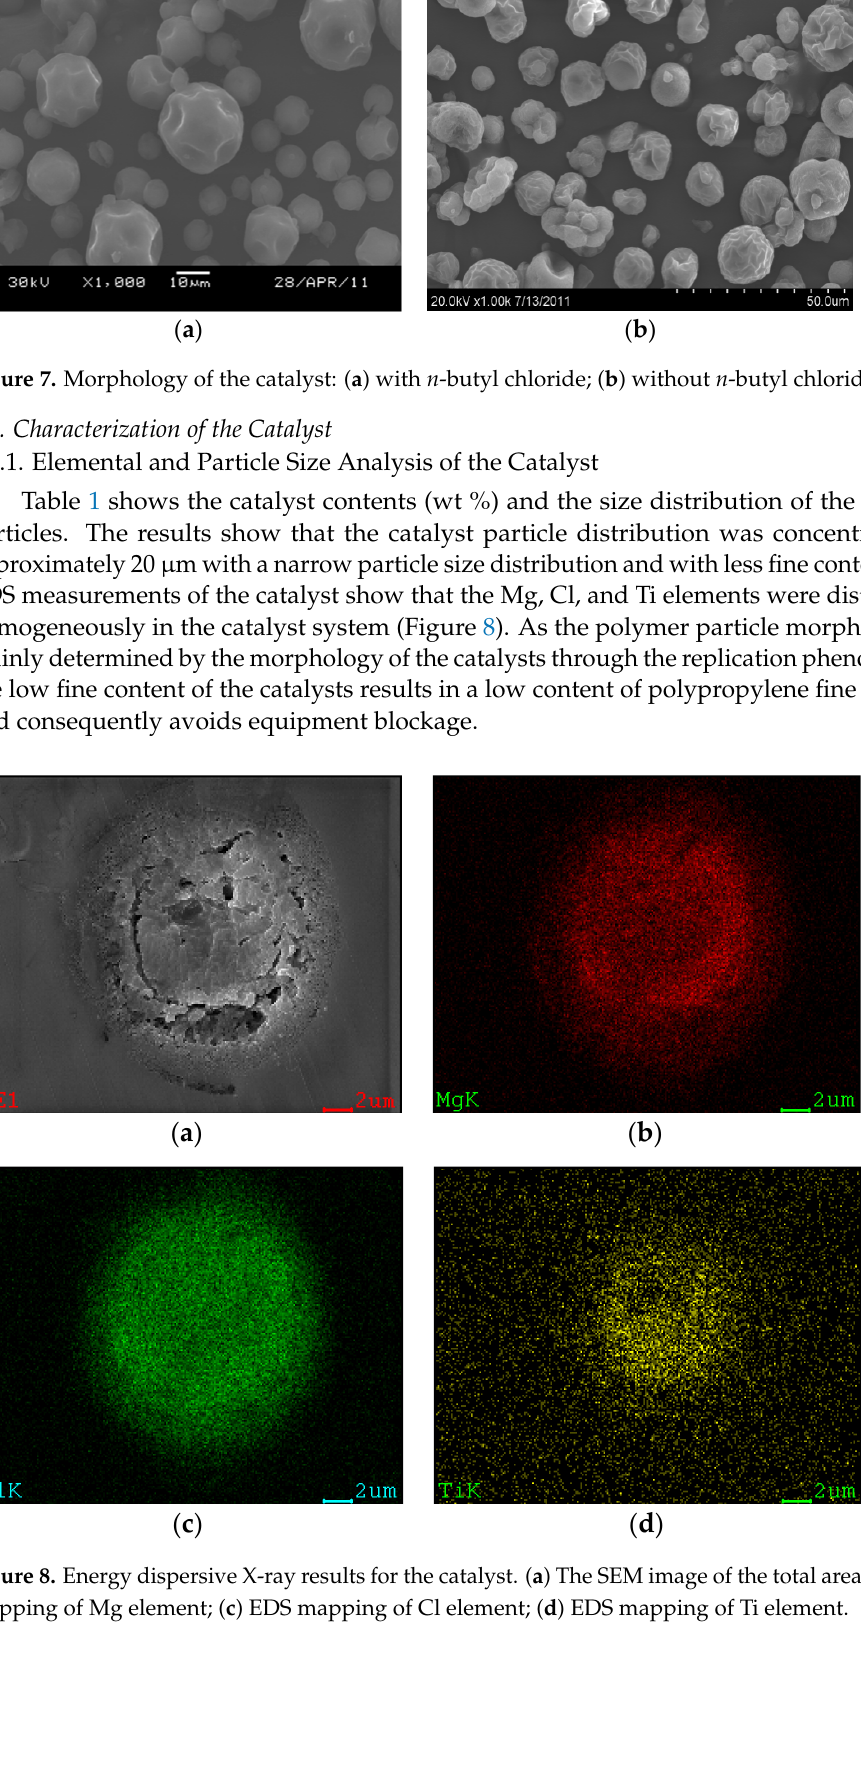
Figure 7. Morphology of the catalyst: ( a ) with n -butyl chloride; ( b ) without n -butyl chloride.